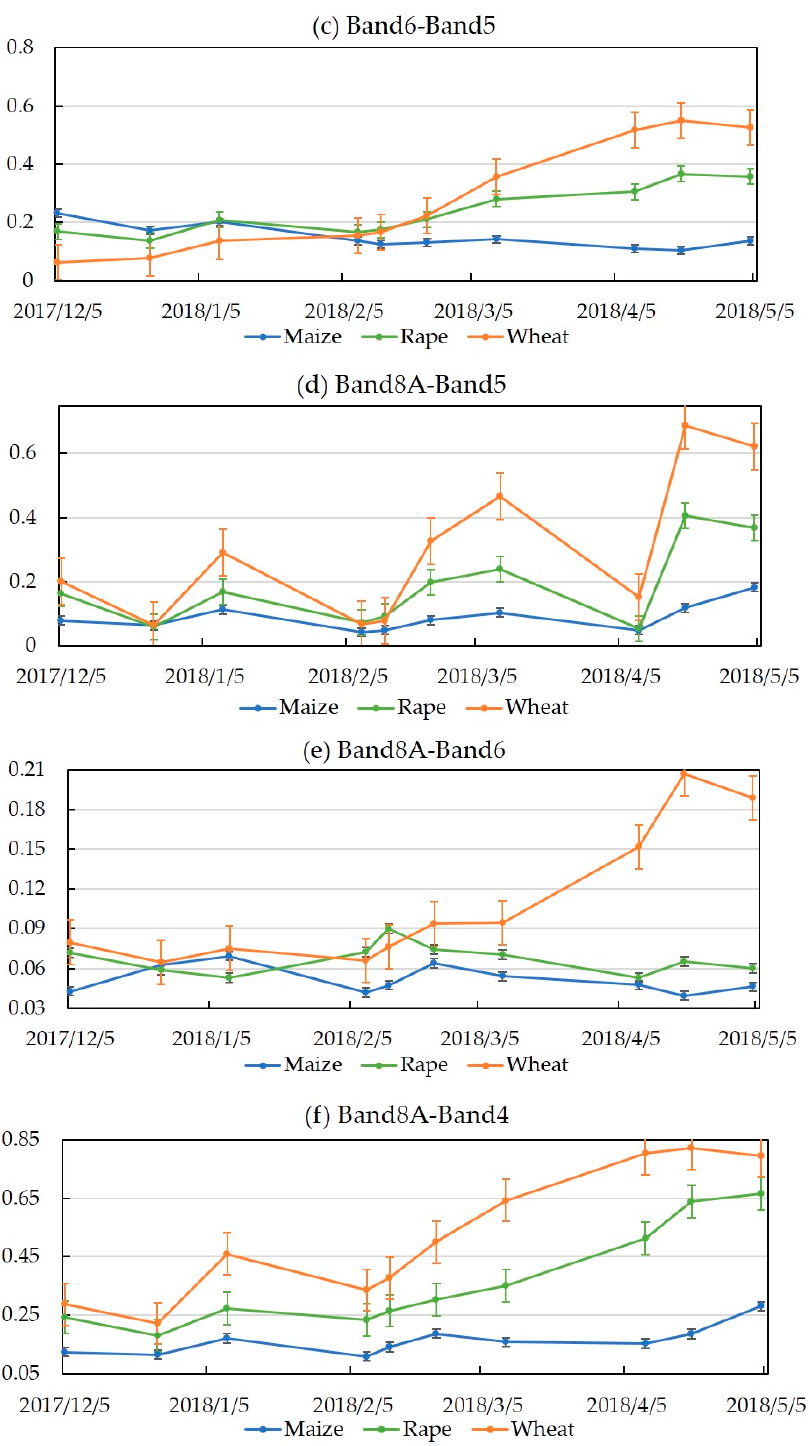
Figure 4. Time-series changes at in red-edge bands of Sentinel-2 data.